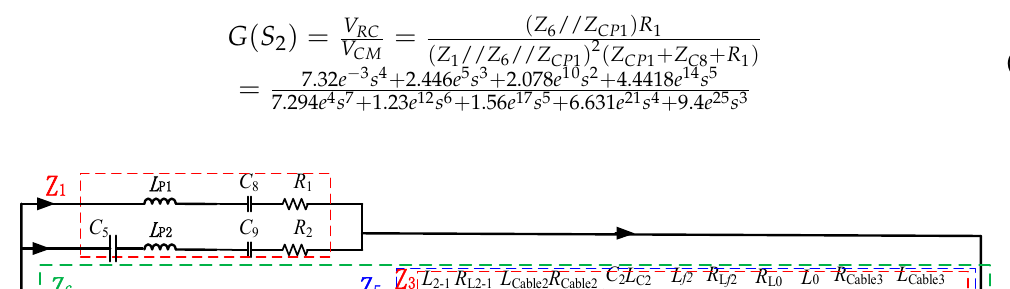
Figure 17. The conducted voltage measured on line impedance stabilization networks (LISNs). The simulation result of the conducted voltage is consistent with the change of the transfer function by bode diagram . Therefore, from Figure 16 and Figure 17, it can be concluded that the CM interference is mainly responsible for the conducted-EMI from the DC power cables of WCS. 5. Filters Design and Experiments The passive filter design method is used to determine the values of the major components in the EMI filter. From above discussion, the conducted interference of the WCS comes mainly from CM interference. Therefore, giving priority to designing the CM filter is taken into account to mitigate the conducted-EMI in WCS in EVs. Then, designing DM filter is considered if necessary.